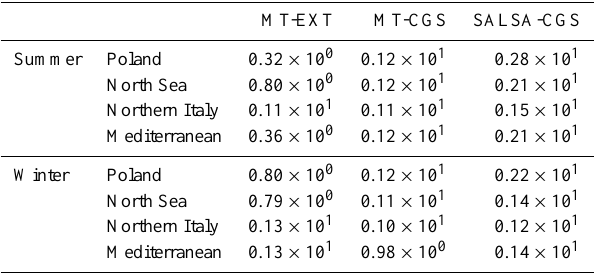
Table 7. Ångström exponent in the wavelength region 532– 1064nm for the four different geographical locations, one summer (22 June 2007, 12:00) and one winter (22 December 2007, 12:00) event, and three model versions, MT-EXT, MT-CGS, and SALSA- CGS. MT-EXT MT-CGS SALSA-CGS